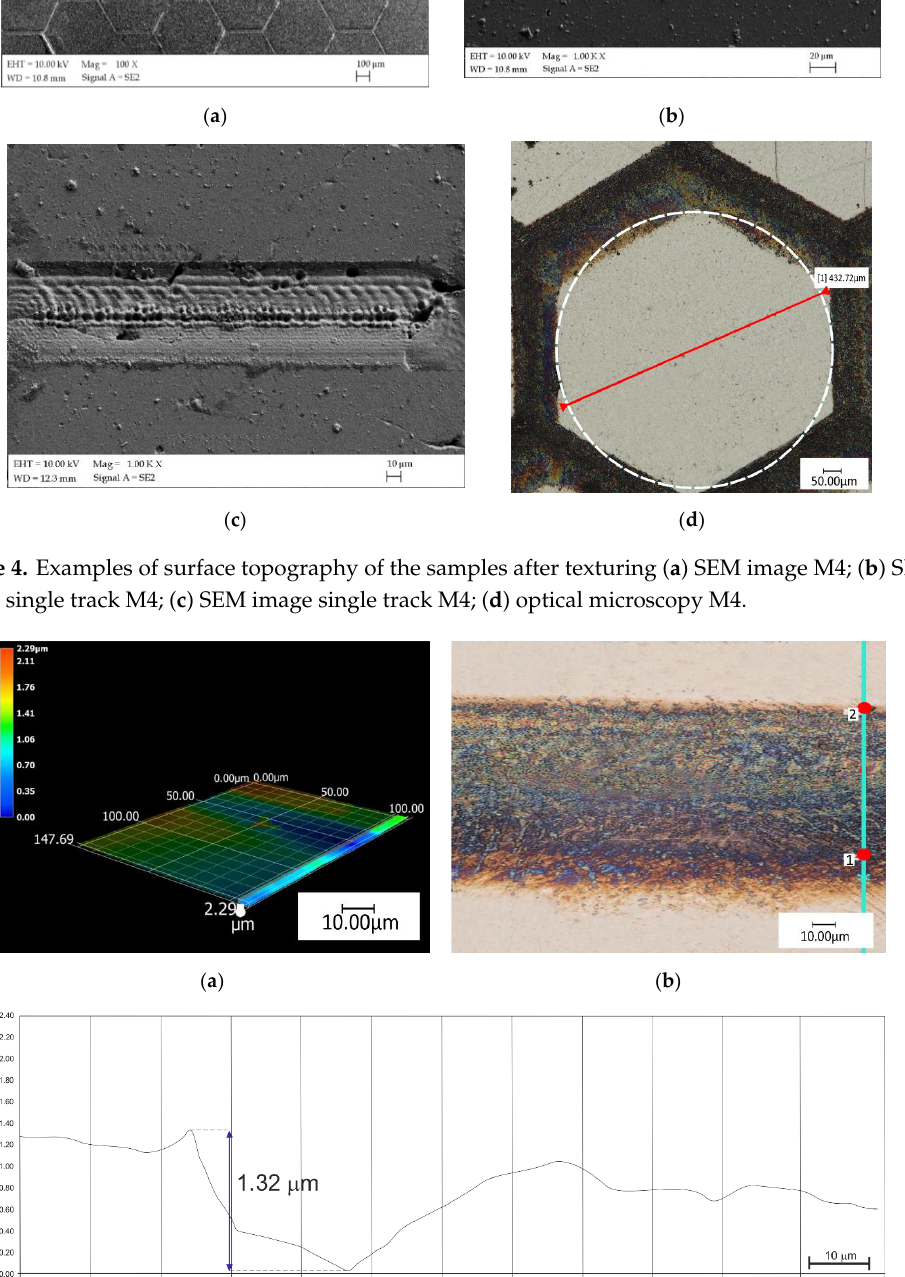
of a single path; ( b ) single track with an indication of the depth measurement location; ( c ) groove